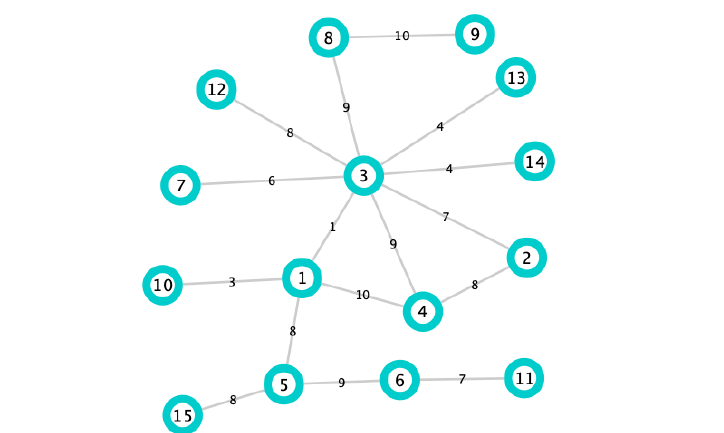
Figure 5. Graph with 15 nodes, 16 edges, and the respective weights.